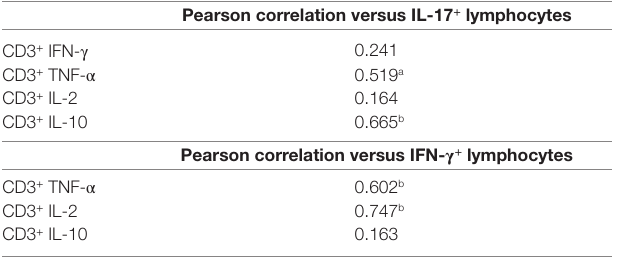
TaBle 2 | Pearson correlation of il-17 or iFn- γ production by tumor infiltrating cD3 + T lymphocytes versus other cytokines ( n = 20). Pearson correlation versus il-17 + lymphocytes